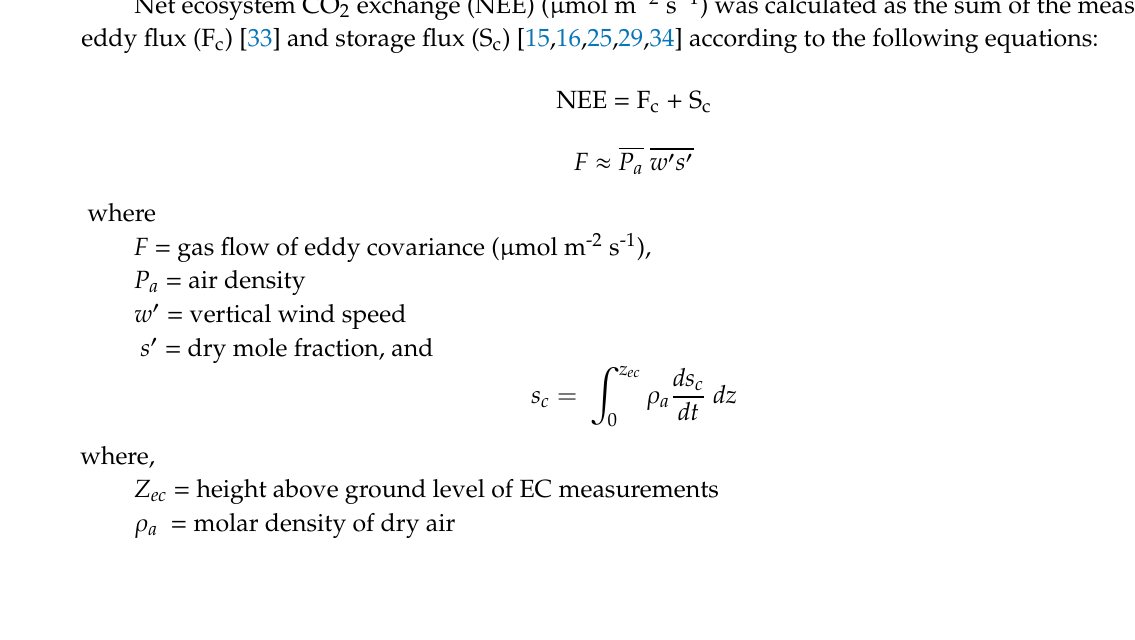
Silver birch ( Betula pendula